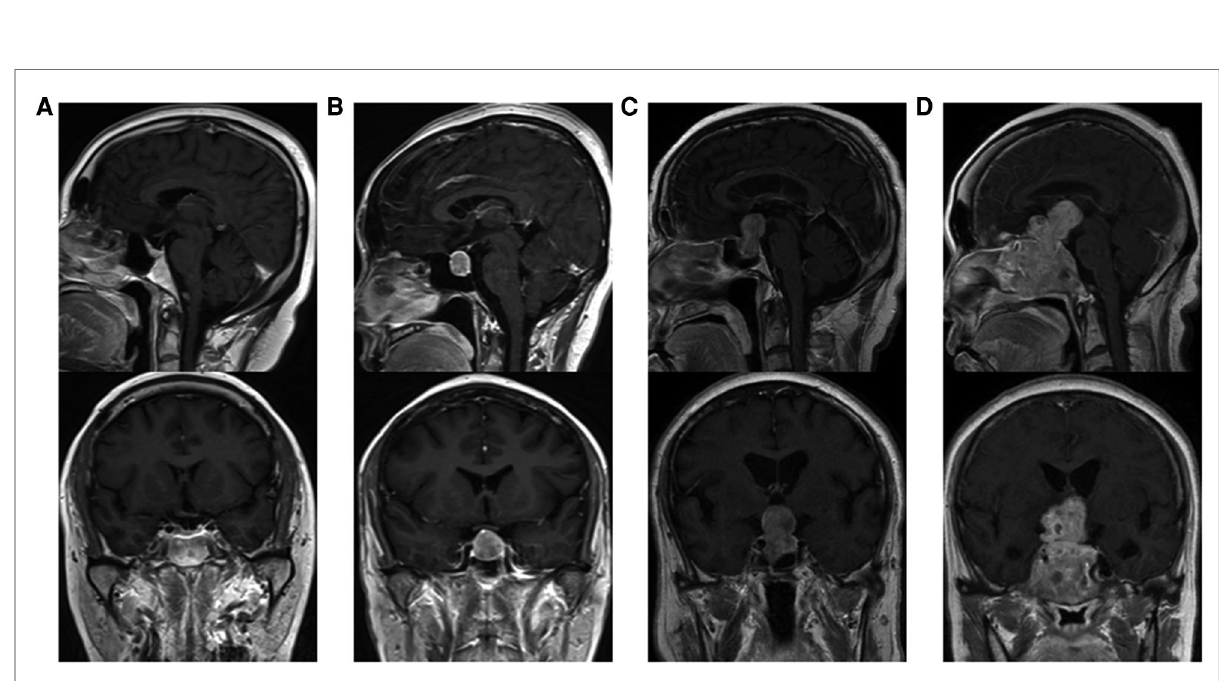
FIGURE 2 Suprasellar extension grades of patients. ( A ) Grade 0, no suprasellar extension. ( B ) Grade A, expanding into the suprasellar cistern. ( C ) Grade B, anterior recesses of the third ventricle obliterated. ( D ) Grade C, the fl oor of the third ventricle grossly